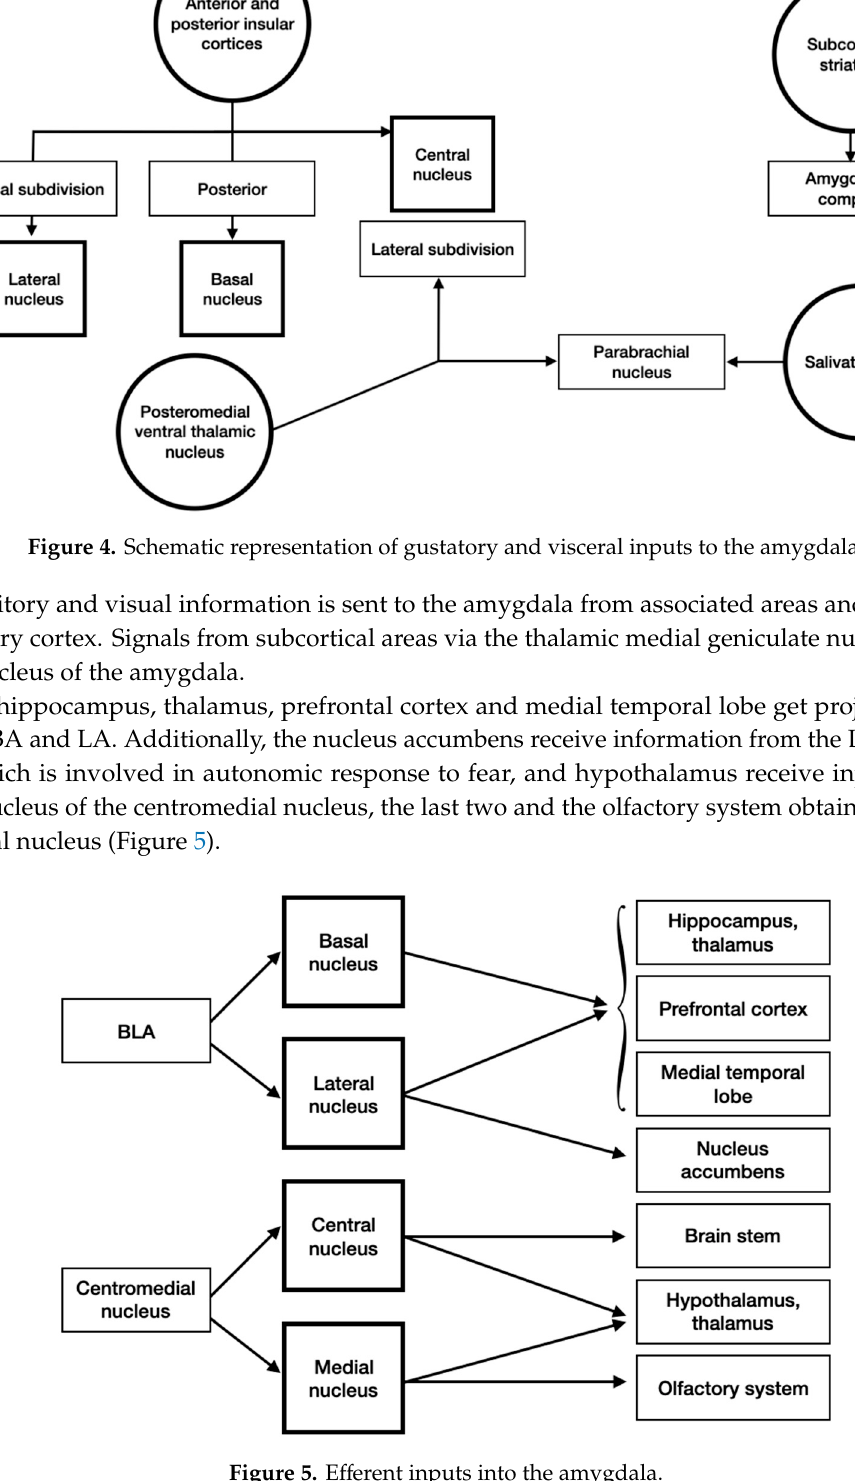
Figure 5. E ff erent inputs into the Figure 5. Efferent inputs into the amygdala. Figure 5. Efferent inputs into the amygdala.